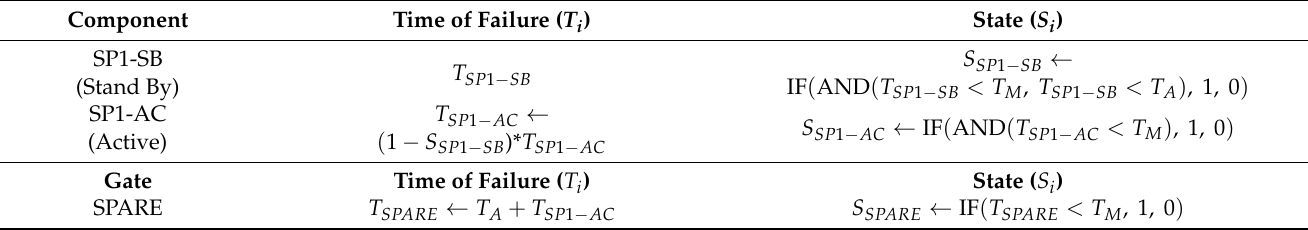
Table 3. Logical expression for deriving the output of a SPARE gate.